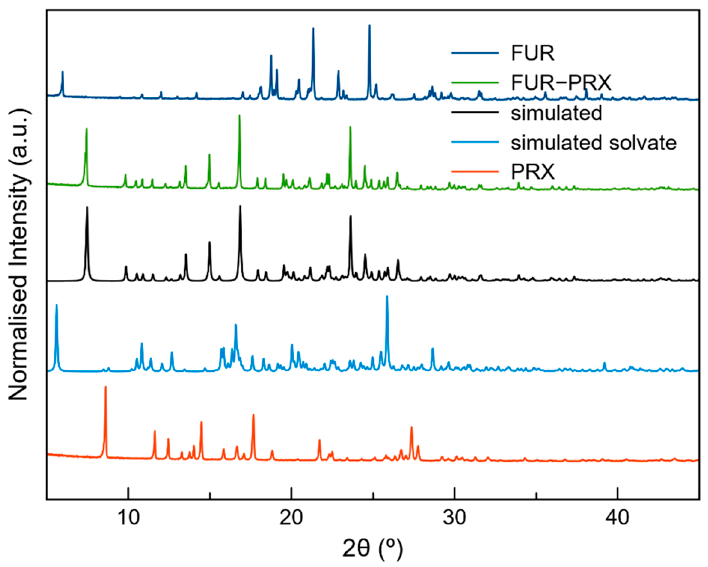
Figure 3. PXRD patterns of the new phase FUR–PRX obtained by liquid-assisted grinding (LAG)